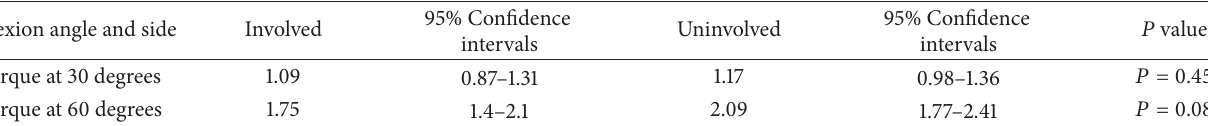
Table 2: Side to side comparison for torque (Nm/kg) generation at 30 and 60 degrees of knee flexion. Flexion angle and